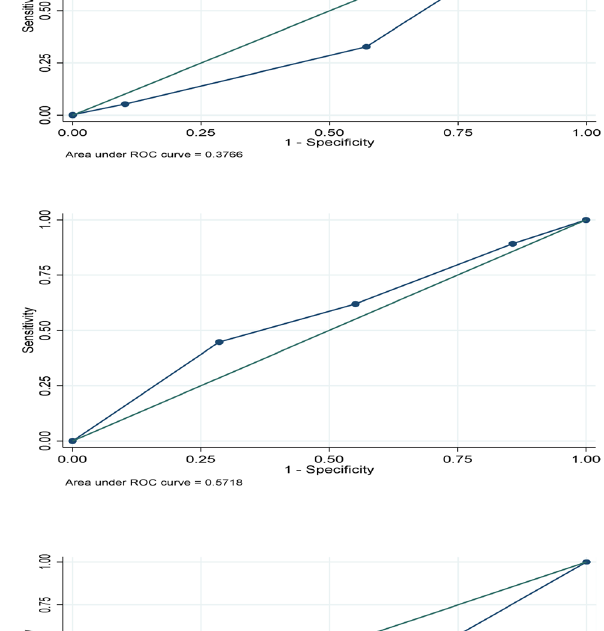
Fig. 12 ROC for IAE. Source: Researchers’ Analysis